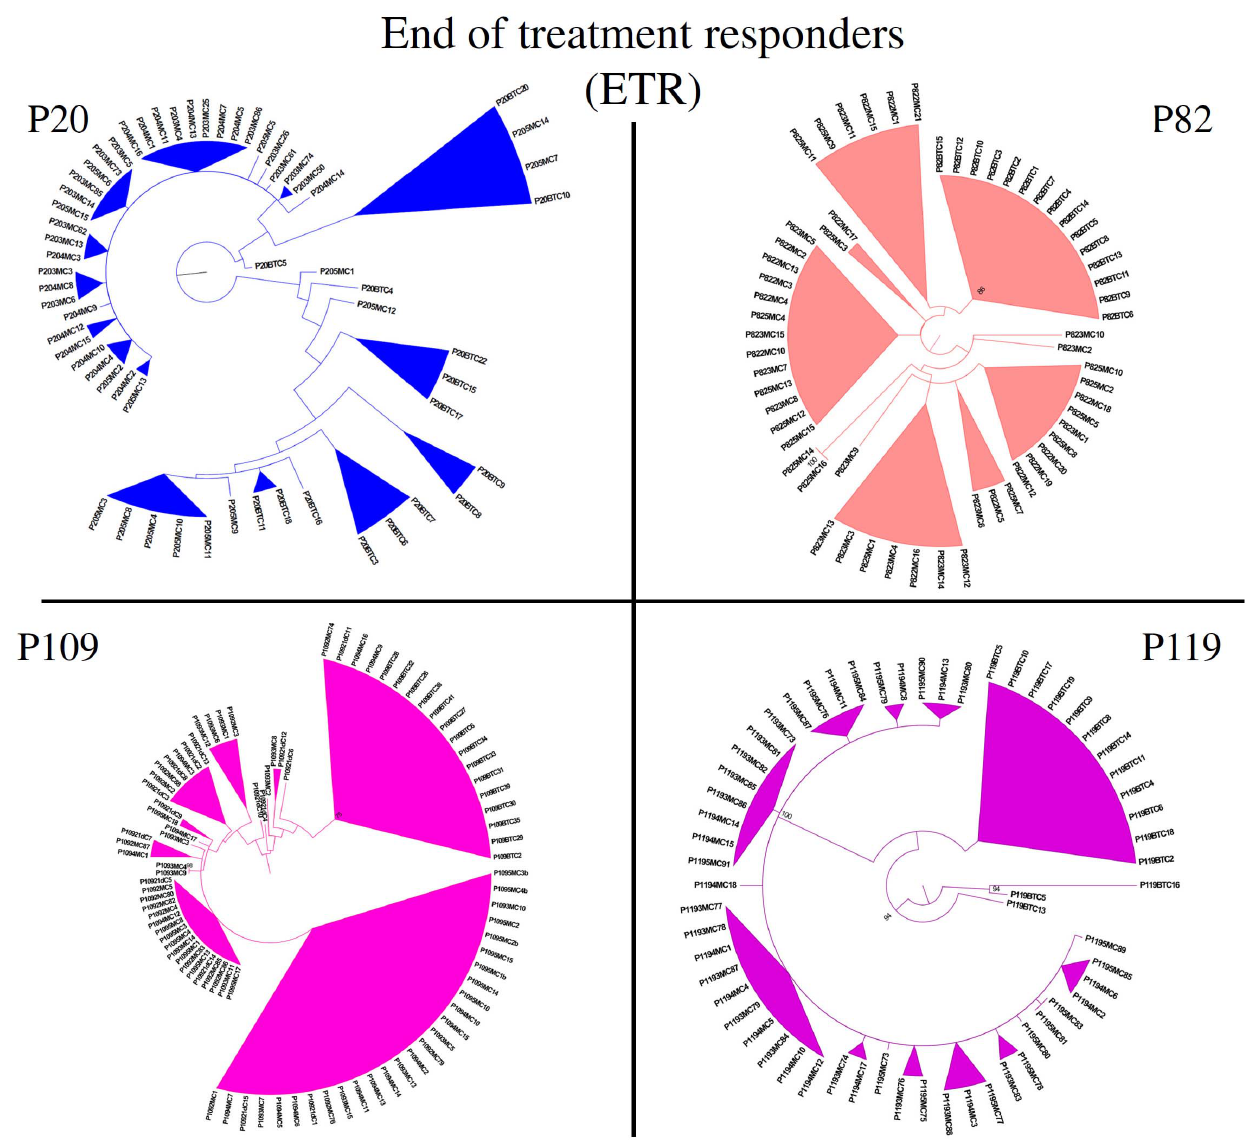
Figure 10. End-of-treatment responders individual phylogenetic trees. Unrooted Maximum-Likelihood phylogenetic trees from ETR patients were constructed with HKY85 substitution model including Gamma distribution parameter (HKY + G). Bootstraps were performed with 1000 replicates. Values above 70% were considered significant. BT - Before treatment; d - days; m - months.